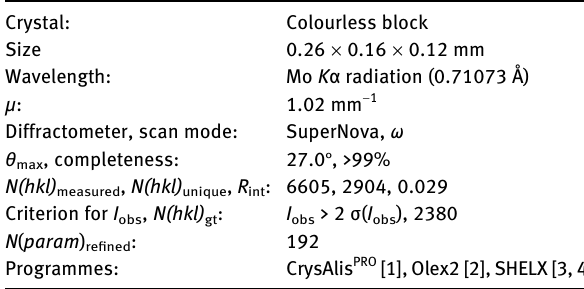
Table  : Data collection and